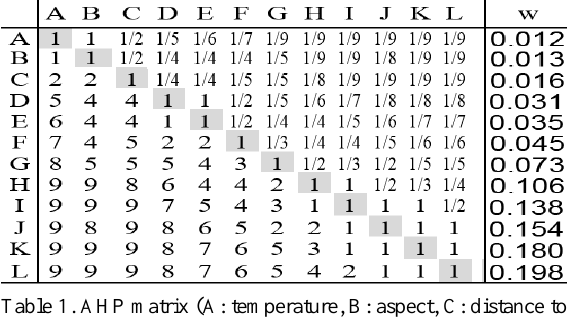
Figure 12. Temperature